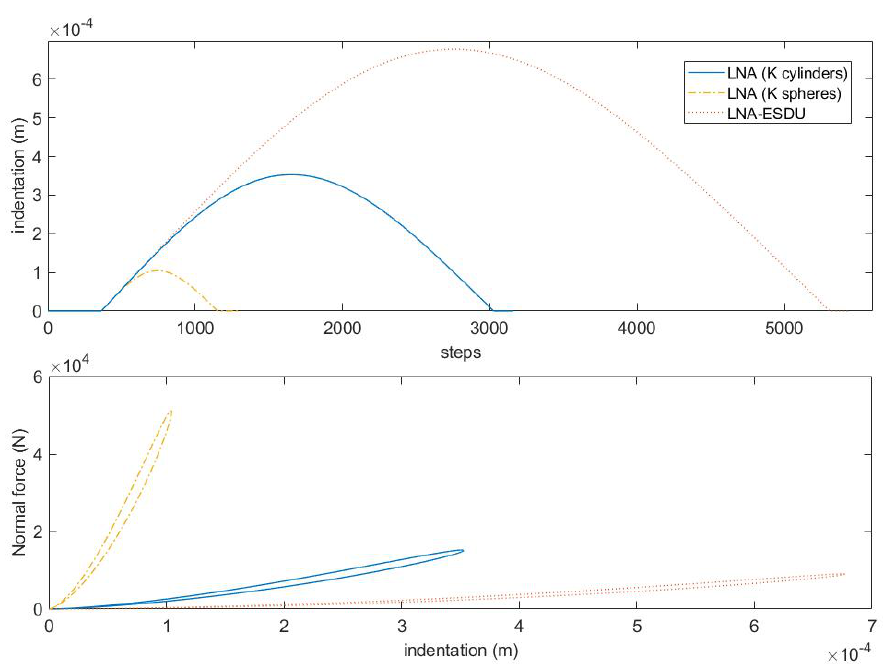
Figure 7. Model comparison considering an asymmetrical impact: from the top to the bottom: indentation vs . number of steps; hysteresis